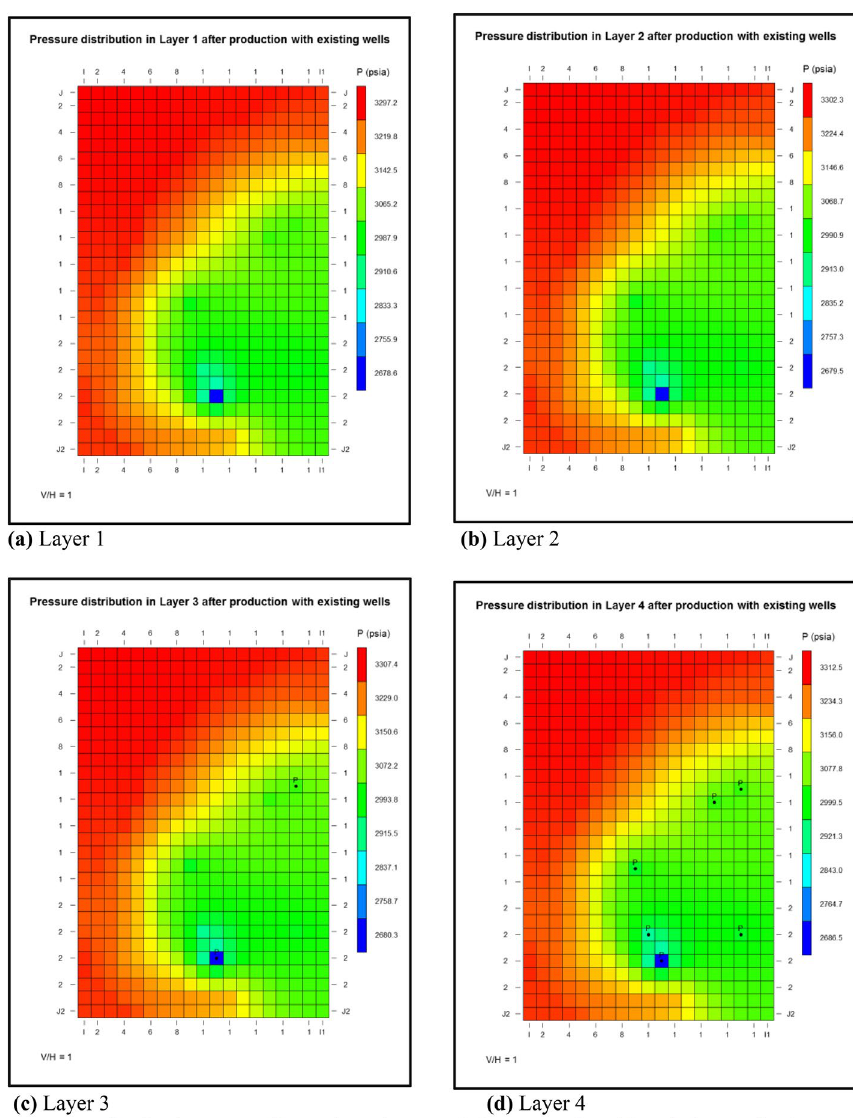
Fig. 5 Pressure distribution maps for various layers of the reservoir with existing wells (15 years simulated production